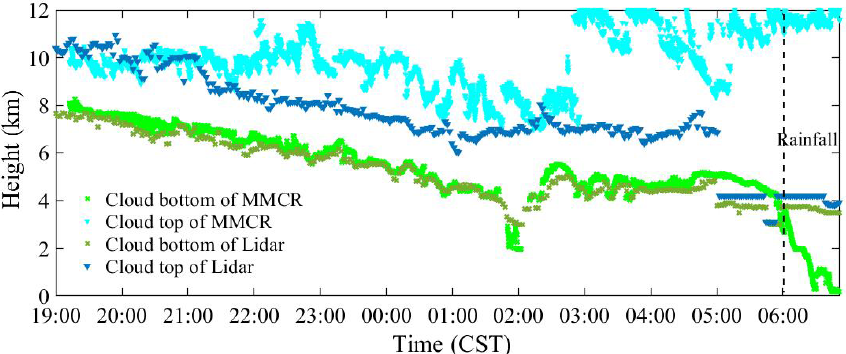
Figure 9. Cloud boundary detected by lidar and MMCR from 8 to 9 June